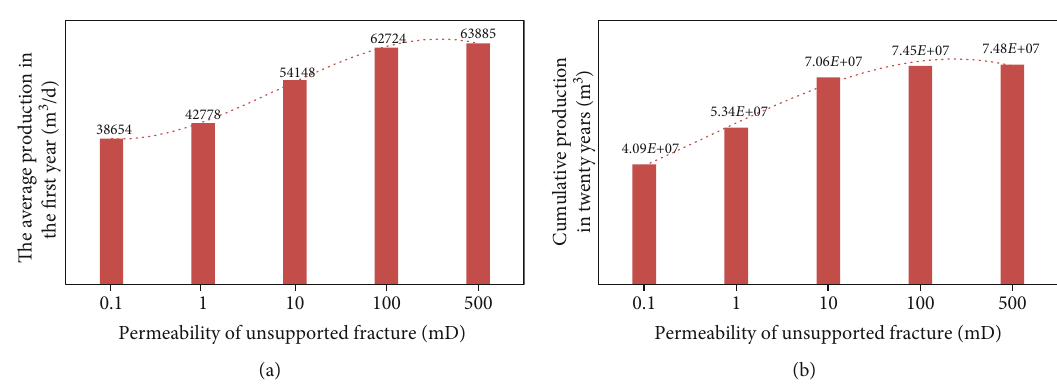
Figure 5: E ff ects of the permeability of unsupported fractures on gas production rate (a) and cumulative production (b).